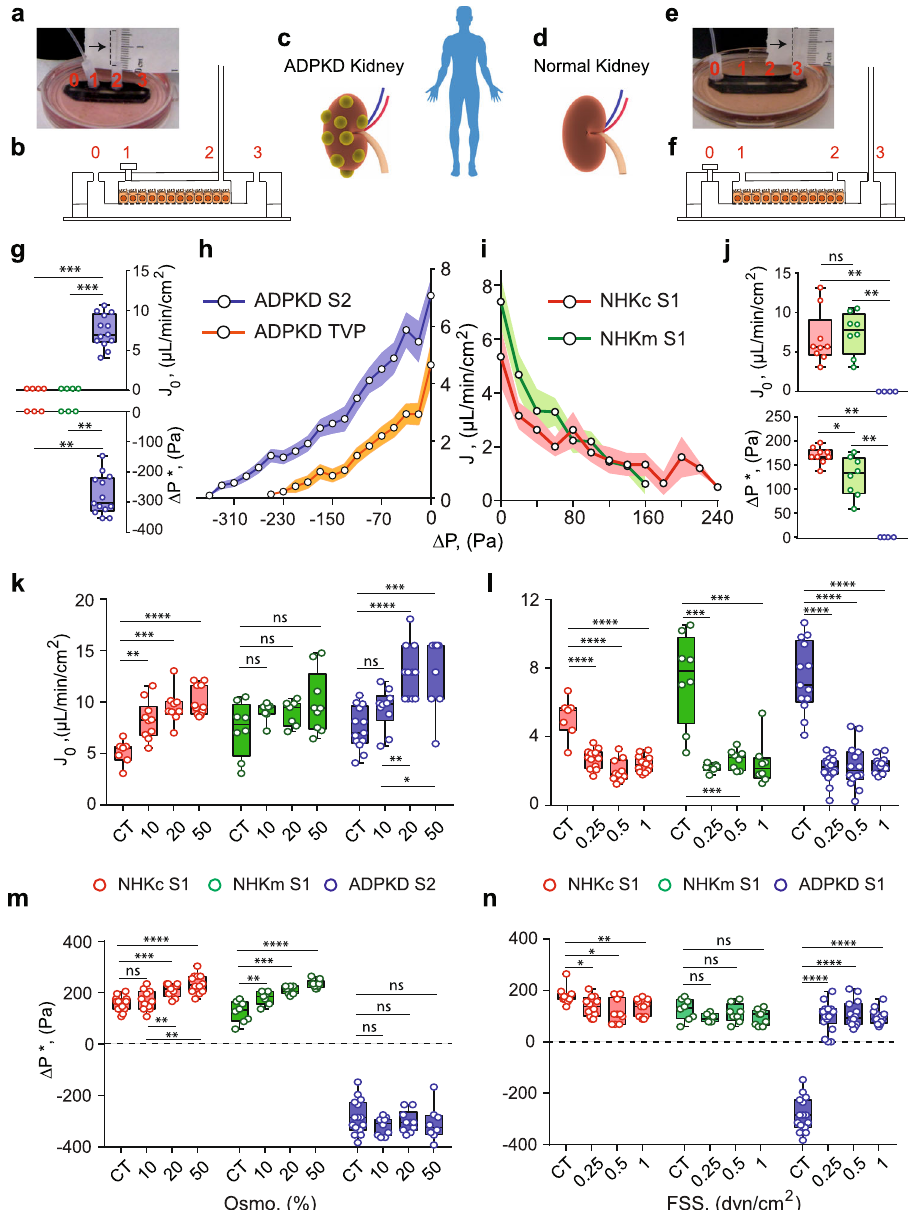
Fig. 4 Cystic cells derived from ADPKD patients pump fl uid in the opposite direction as normal human kidney cells. a , b A snapshot and schematic of MFKP in setup-2 (S2). A cystic ADPKD kidney ( c ) and an normal kidney ( d ) derived from patients. e , f A snapshot and schematic of the MFKP in setup-1 (S1). g Measured J 0 , and Δ P *, for NHKc ( N = 4, biological replicates), NHKm ( N = 4) and ADPKD ( N = 13) epithelia using S2. For J 0 , *** p NHKc-ADPKD = *** p NHKm-ADPKD = 0.0008 and for Δ P *, ** p NHKc-ADPKD = ** p NHKm-ADPKD = 0.0036. h Pump performance curve (PPC) of